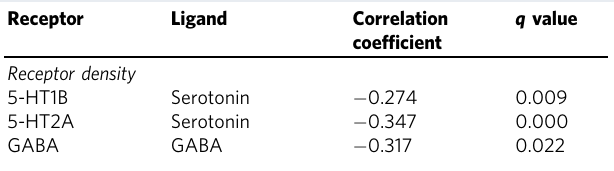
Table 4 Neurotransmitter receptors showing density and gene expression correlations with regional control energy required to transition from the Integrated to the Segregated